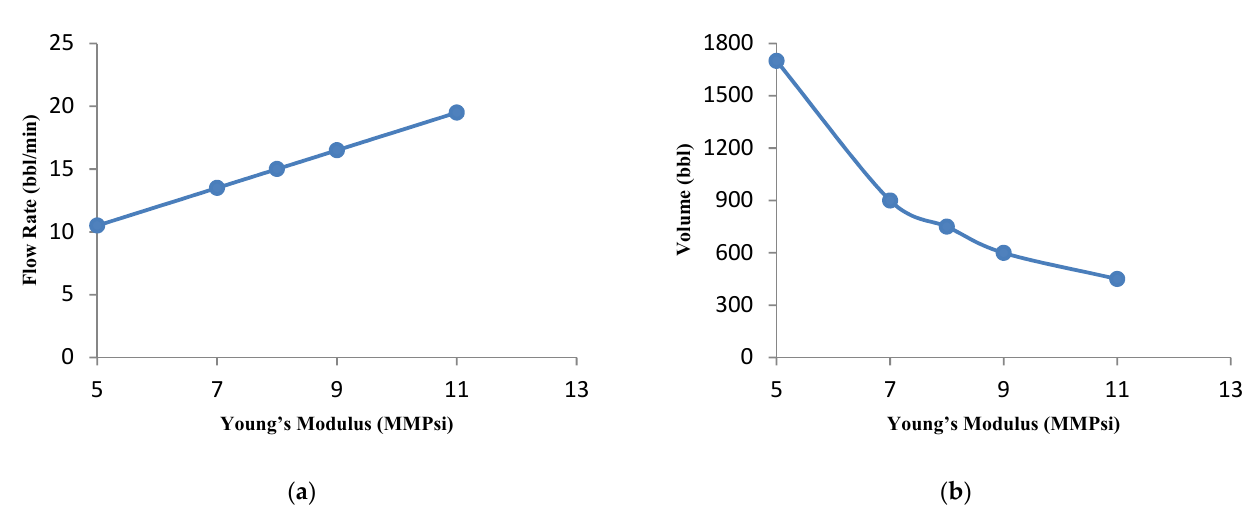
Figure 19. The impact of Young’s modulus on the flow rate ( a ) and acid volume ( b ) for a 540 bbl acid volume.